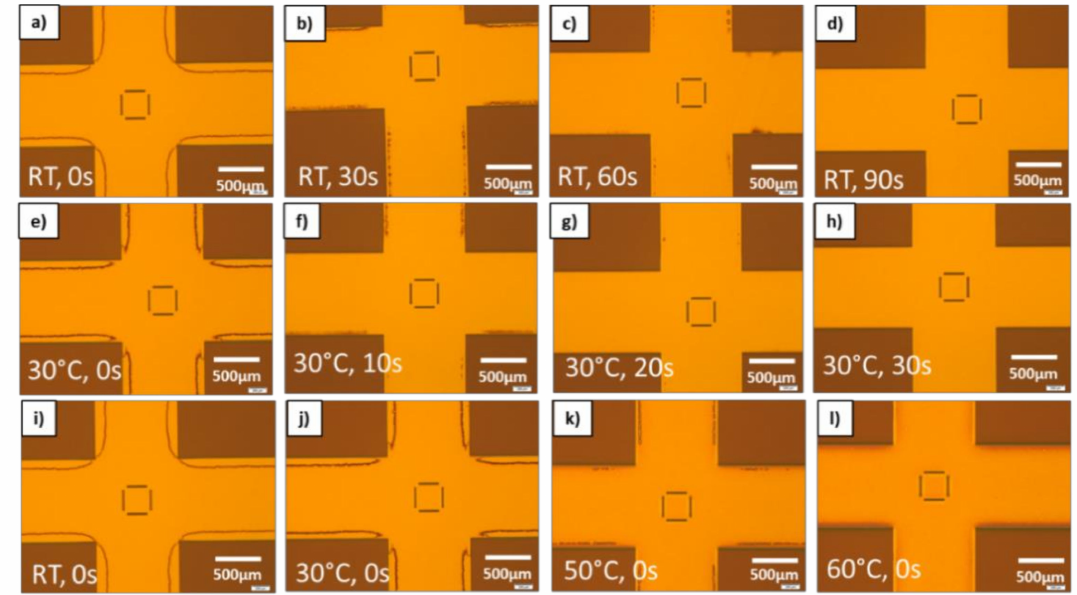
Figure 10. Filling behavior matrix for different temperatures and delay times until the defects completely. ( a – d ) Constant room temperature and increasing delay time in 30 s steps. ( e – h ) Constant elevated temperature at 30 ◦ C and delay time increase by 10 s steps. ( i – l ) Constant delay time of 0 s and increasing temperature from RT up to 60 ◦